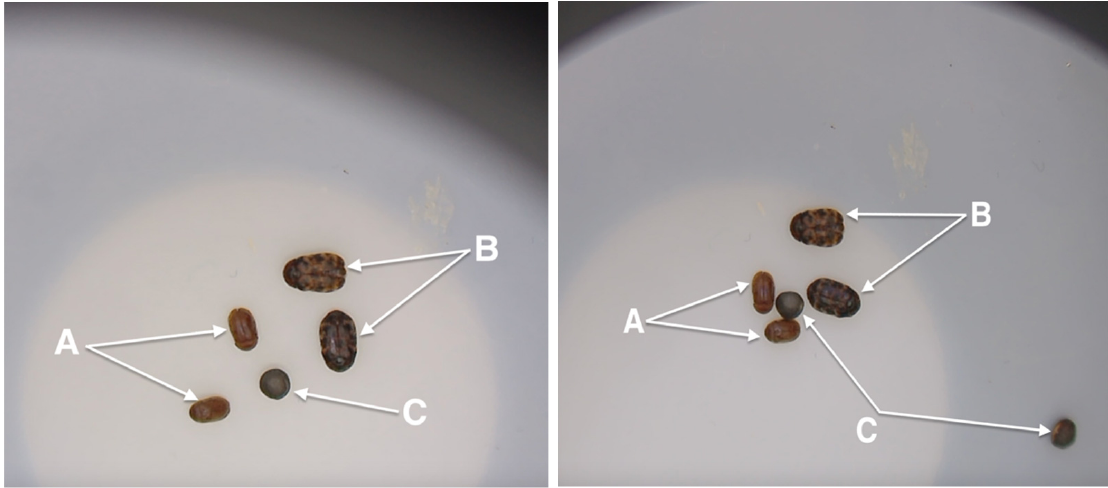
Figure 4. Two examples of actual images of the cigarette beetle (A), warehouse beetle (B), and black canola seeds (C) used in training the model.